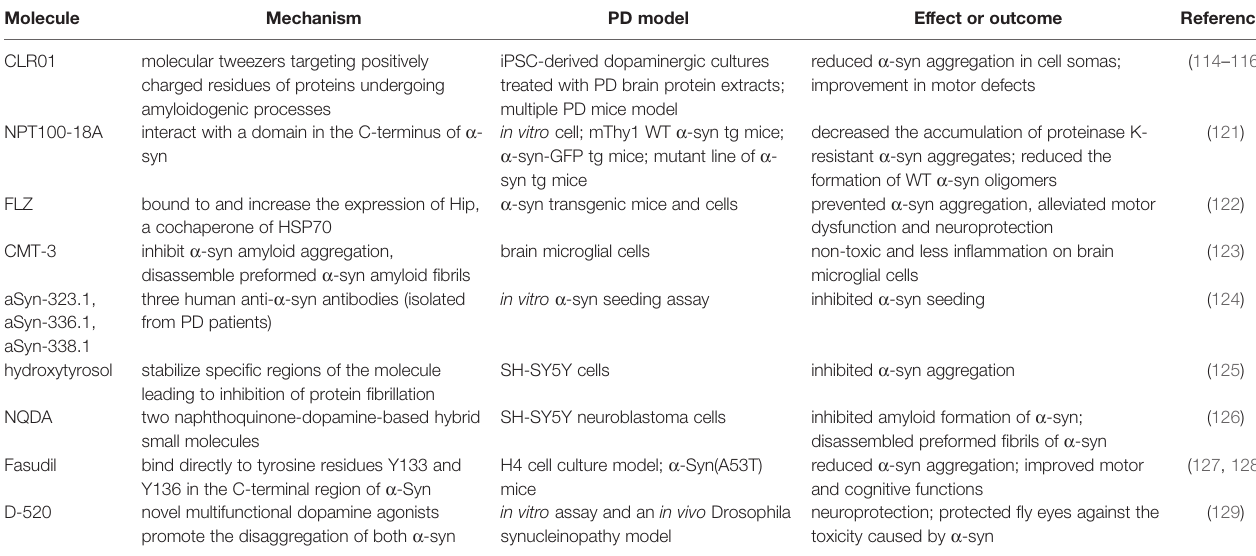
TABLE 2 | Molecules prevent a -syn aggregation and decrease